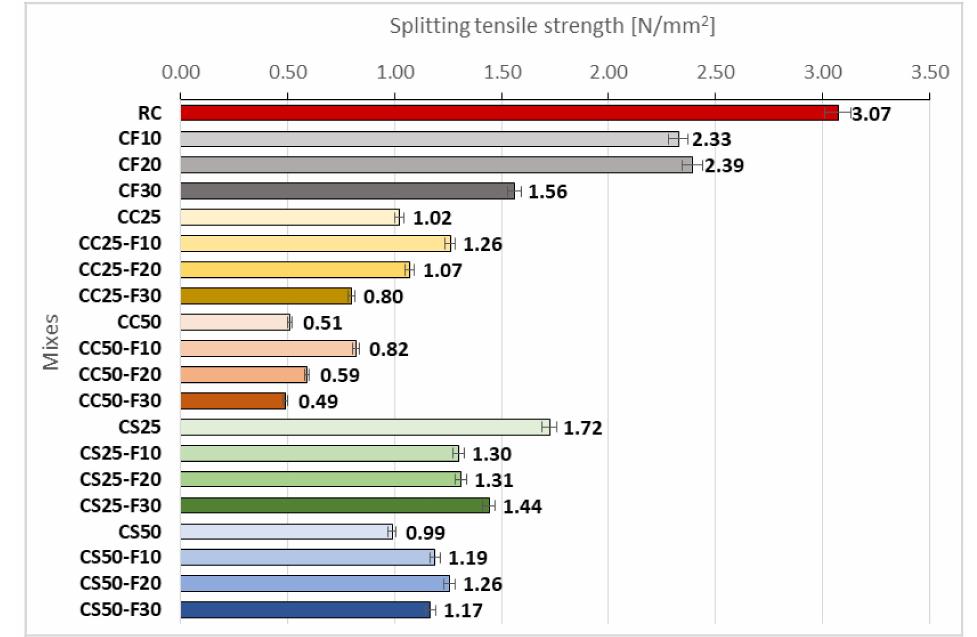
Figure 19. Splitting tensile strength of the composite samples [N/mm 2